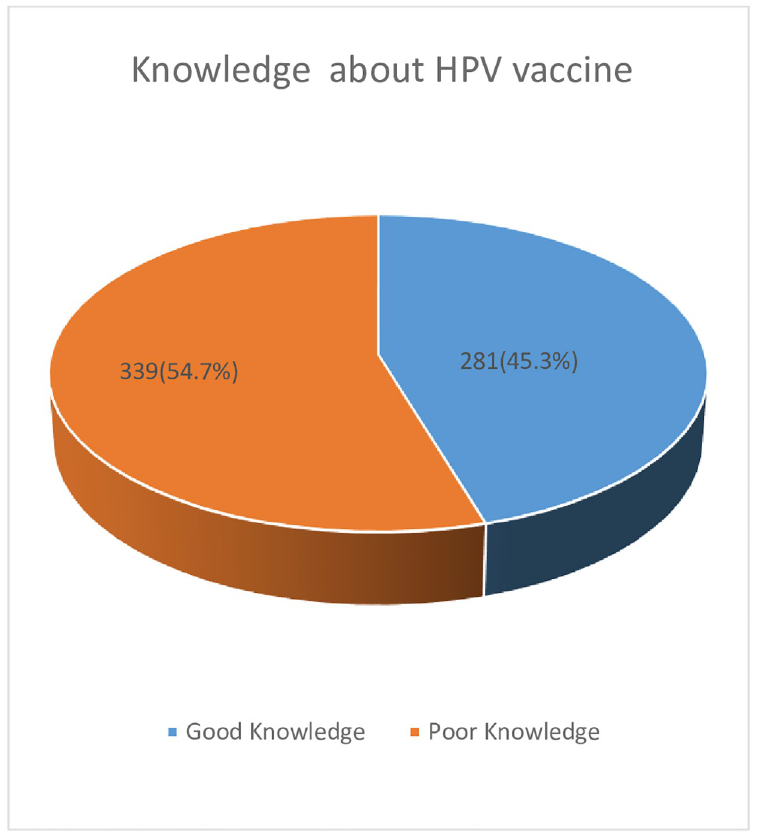
Fig 2. Knowledge of respondents about HPV vaccine, Bahir Dar, Ethiopia,